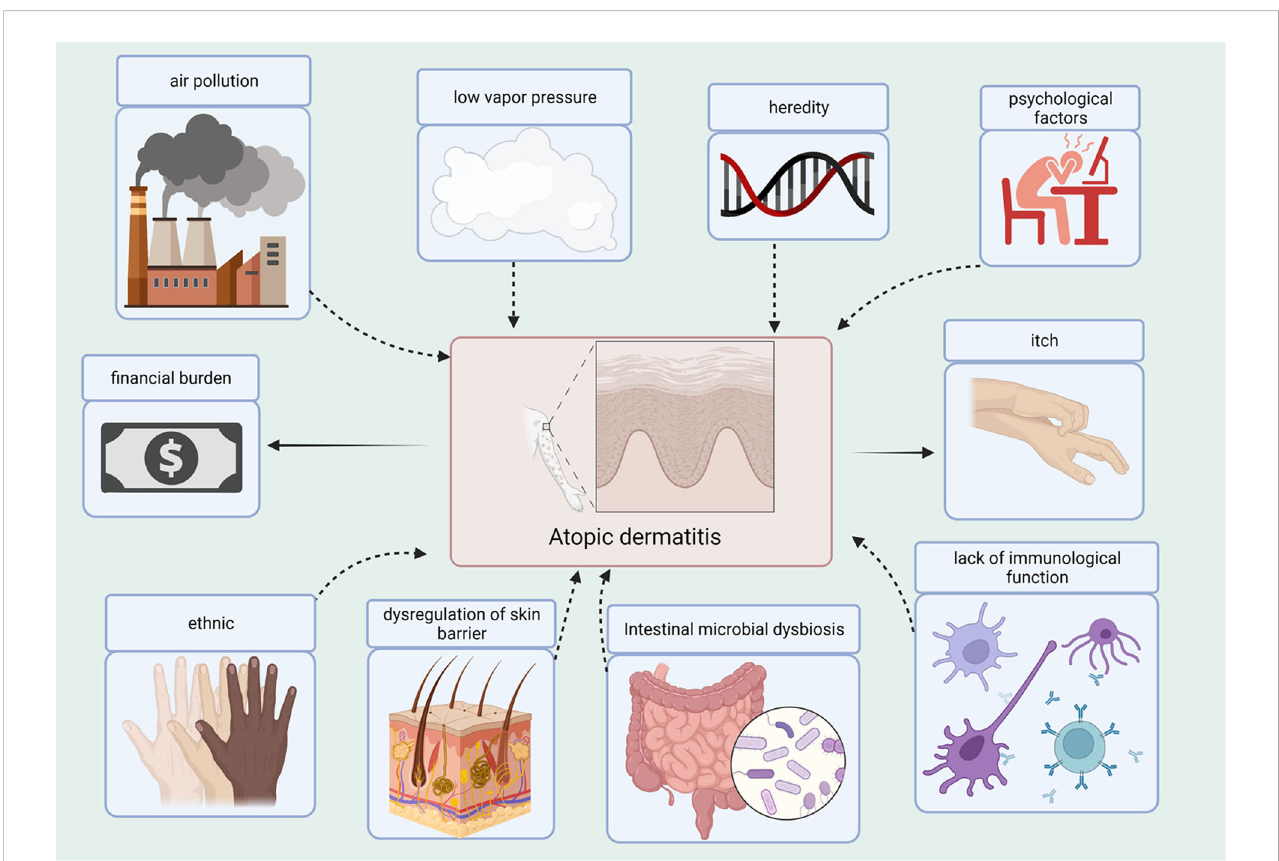
FIGURE 1 Causes and Consequences of the AD. Several factors contribute to the development of AD, such as air pollution, low vapor pressure, heredity, psychological factors, ethnicity, dysregulation of the skin barrier, dysbiosis of gut microbes, and lack of immune function. AD contributes to the itchiness and fi nancial